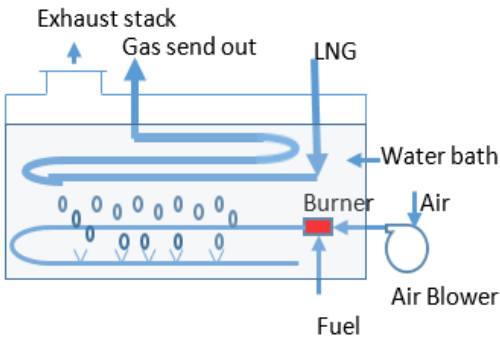
Figure 5. Submerged combustion vaporizer.